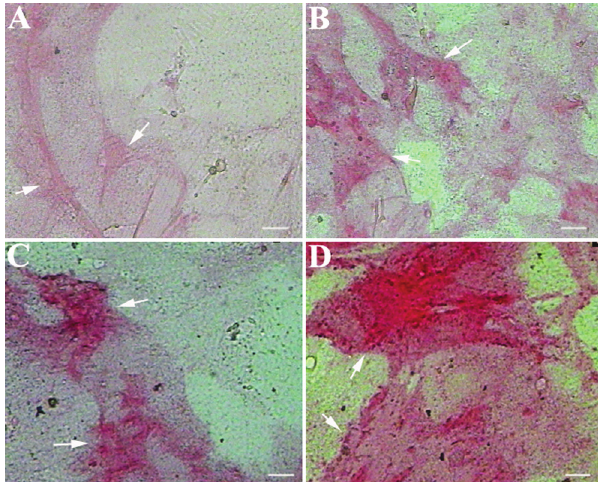
Figure 3 - Treatment of undifferentiated MSCs with CQ extract in osteogenic media accelerates osteoblast differentiation: MSCs grown in osteogenic media alone show mild ALP activity by the 7th day of the treatment (A). Furthermore, MSCs grown in osteogenic media supplemented with 100, 200 or 300 µg/mL CQ extract show intense, dose-dependent ALP activity (B, C and D, respectively). Arrows indicate differentiating MSCs. Scale bar = 25 µm